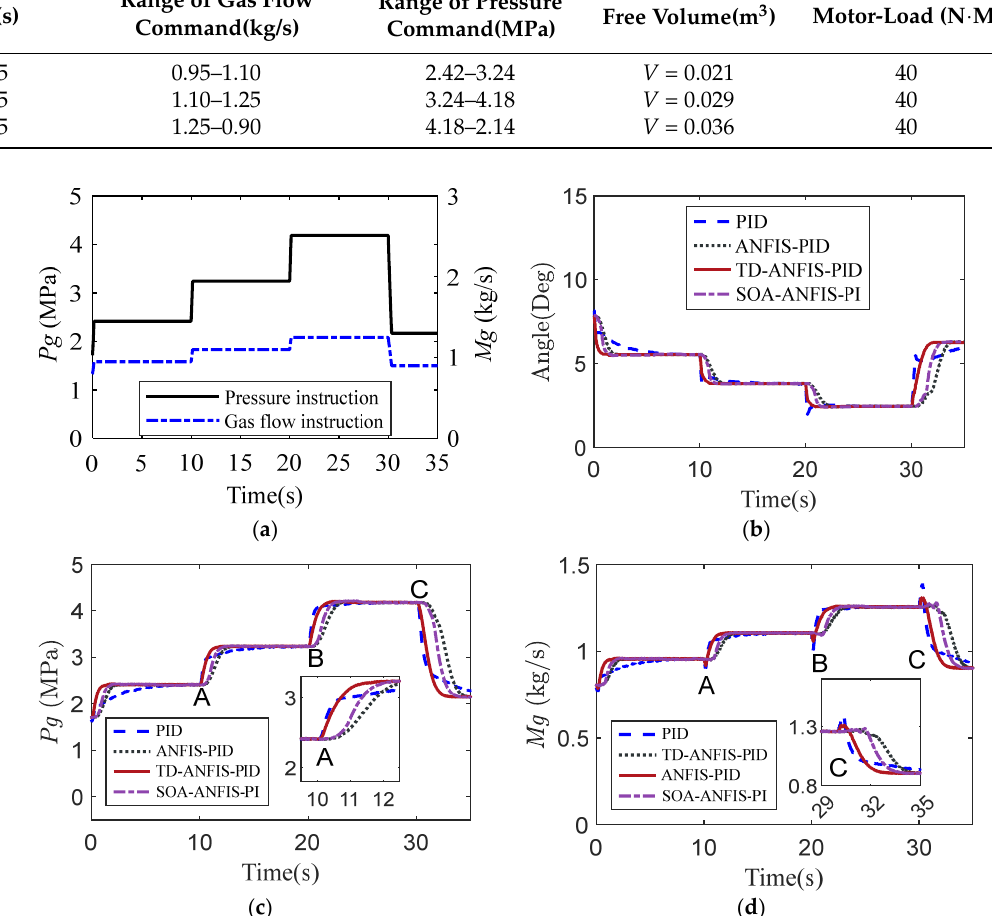
Figure 15. Control results of the HIL ( a ) Control instruction; ( b ) Control input; ( c ) Gas flow response;